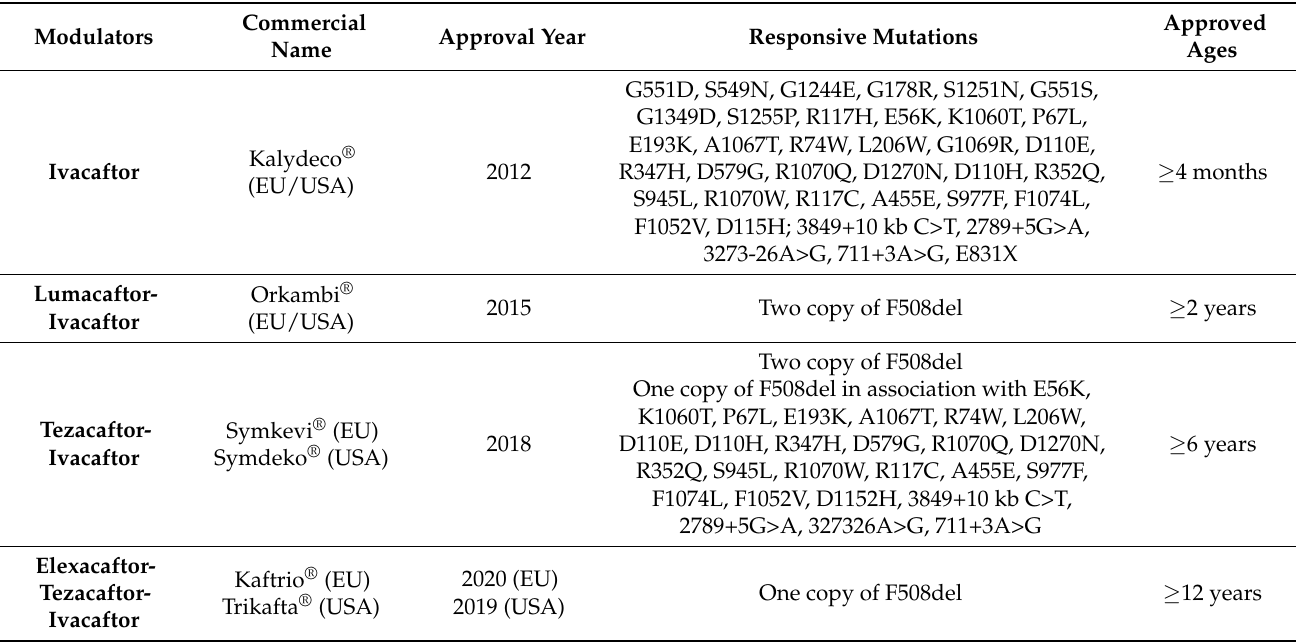
Table 1. Approved CFTR modulators and their indications.